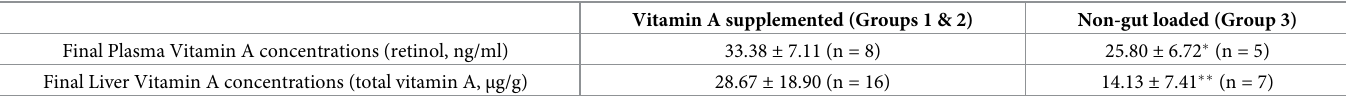
Table 3. Plasma and liver vitamin A concentrations from geckos receiving vitamin A gut loaded BSF larvae versus those receiving non-gut loaded BSF larvae.